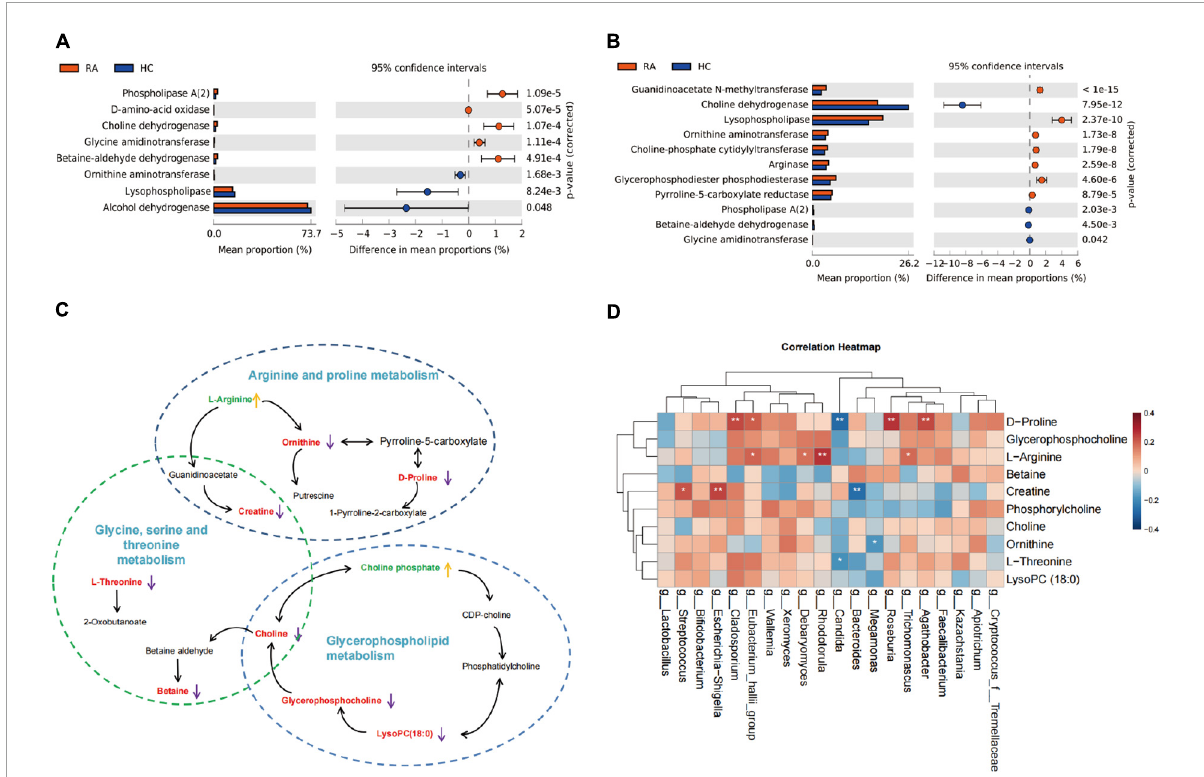
FIGURE6 The function predictive and omics association analysis. (A) The enzymes prediction of bacterial metabolome between RA and HC. (B) The enzymes prediction of fugal metabolome between RA and HC. (C) The metabolic network diagram of the three enrichment pathways based on 10 differential metabolites. (D) The network mapping diagram of the differential metabolites, bacterial, and fungus. RA, rheumatoid arthritis; HC, healthy